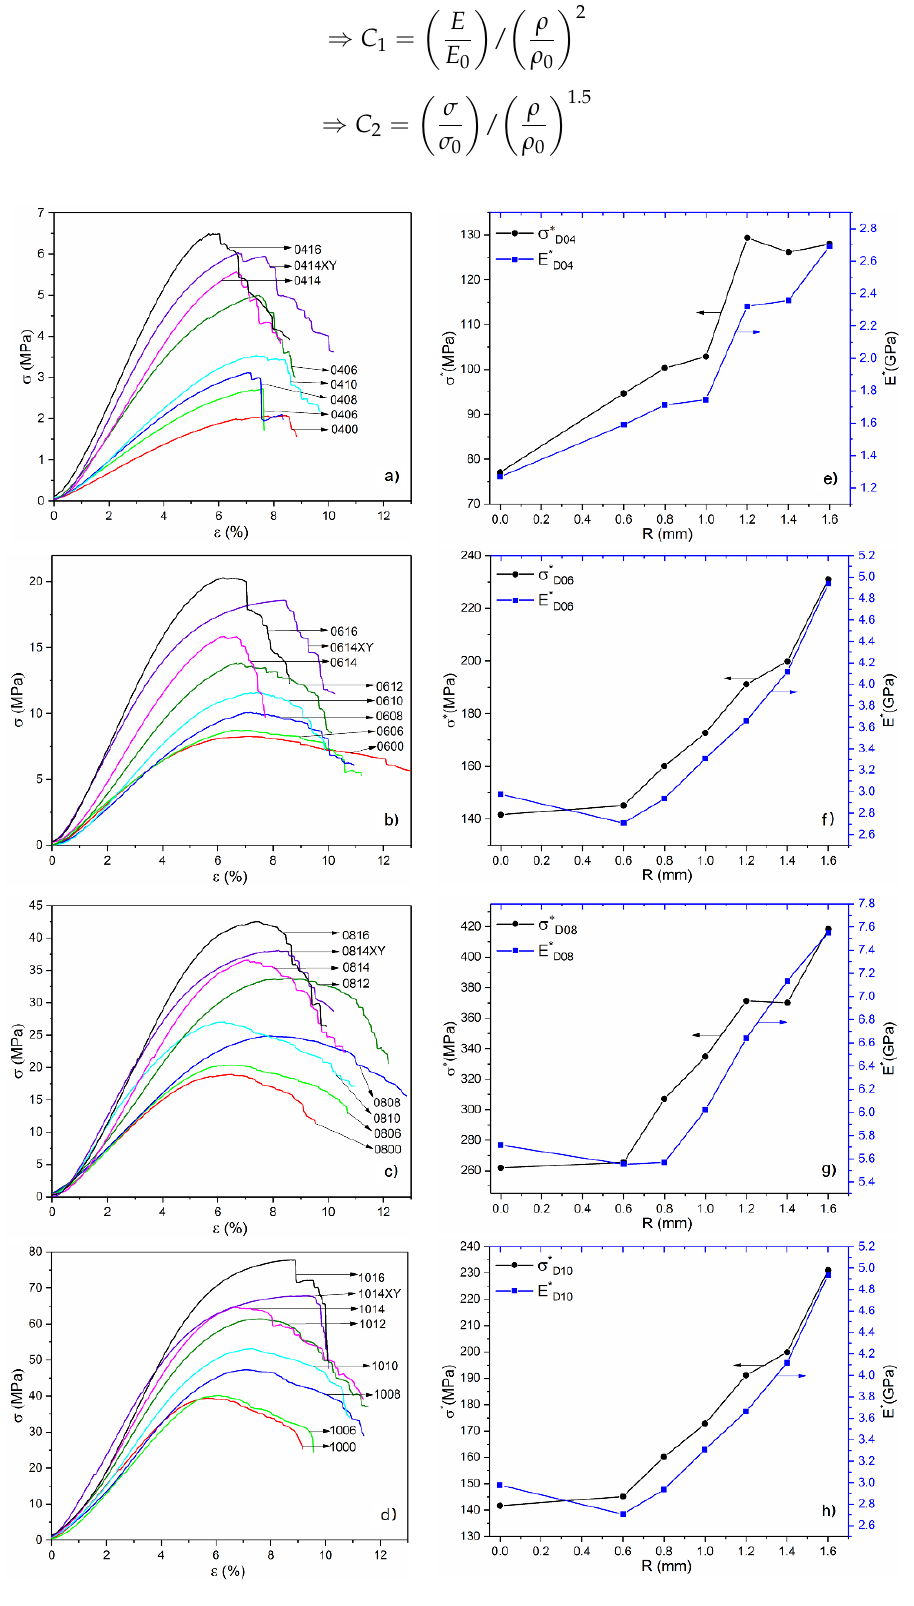
Figure 6. ( a – d ) The stress–strain curves; ( e – h ) the corresponding relative ultimate stress 𝜎 ∗ and relative modulus 𝐸 ∗ .